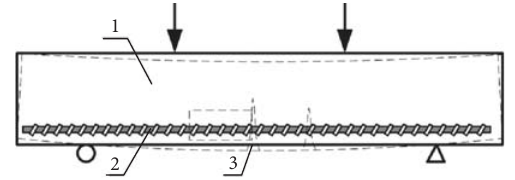
Fig. 2. Scheme of pull-out bond test: 1 – reinforcing bar;